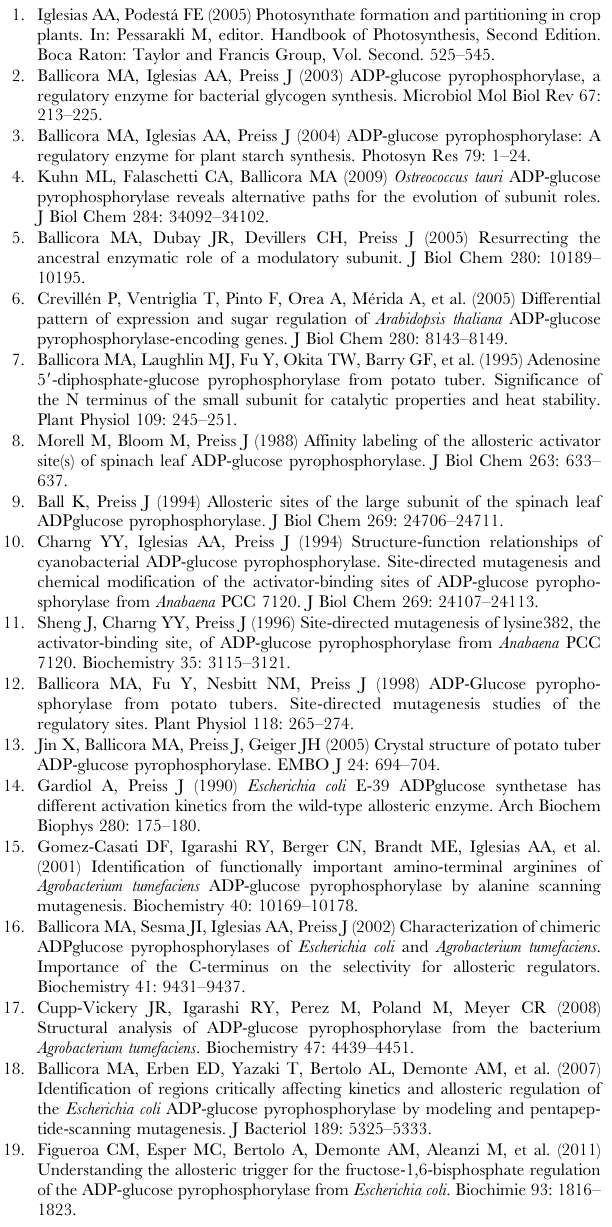
Table S1 Oligonucleotides used for introducing muta- tions into the sequences coding for the Anabaena sp. PCC 7120 and potato tuber ( Stu S and Stu L subunits) ADP-Glc